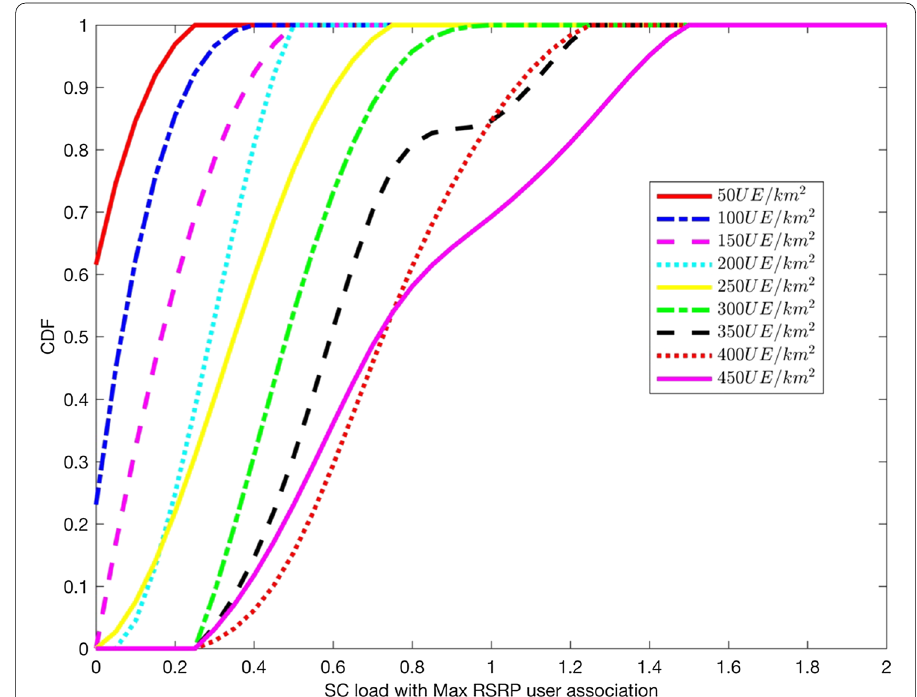
Fig. 8 SC load of Max RSRP user association versus the different density of UEs